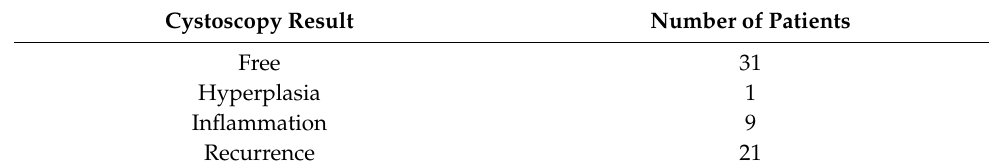
Table 1. Cystoscopy results for the cohort.